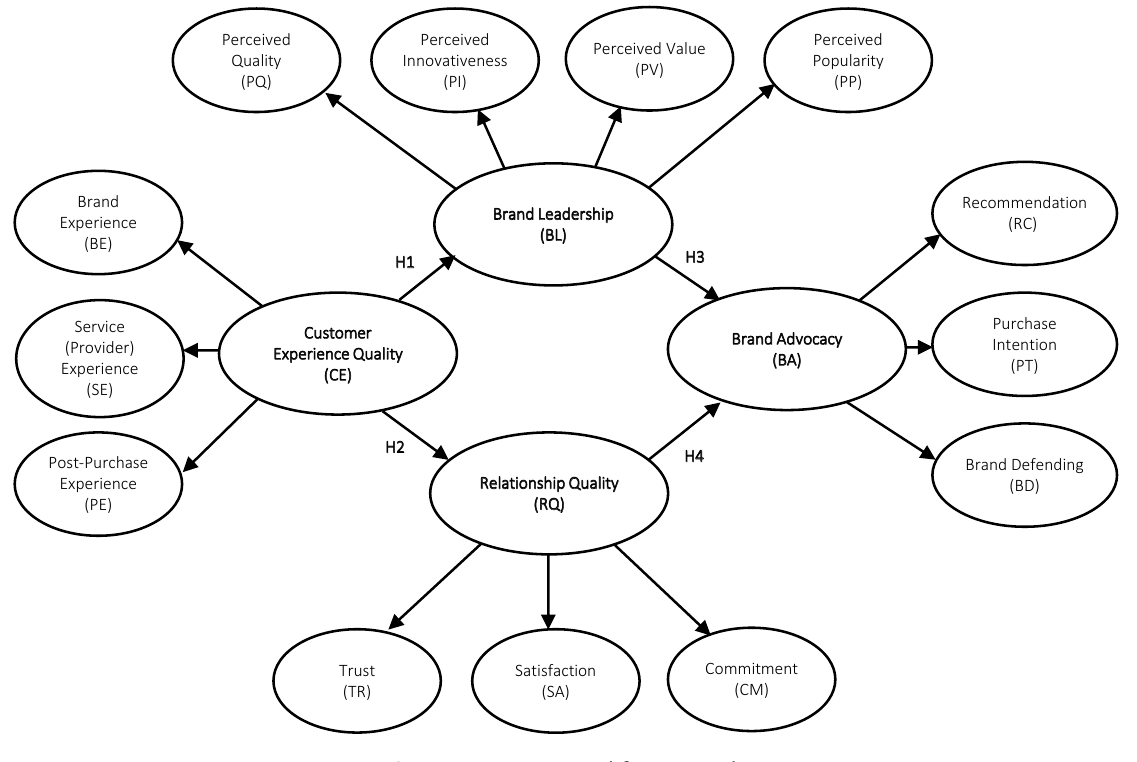
Figure 1. Conceptual